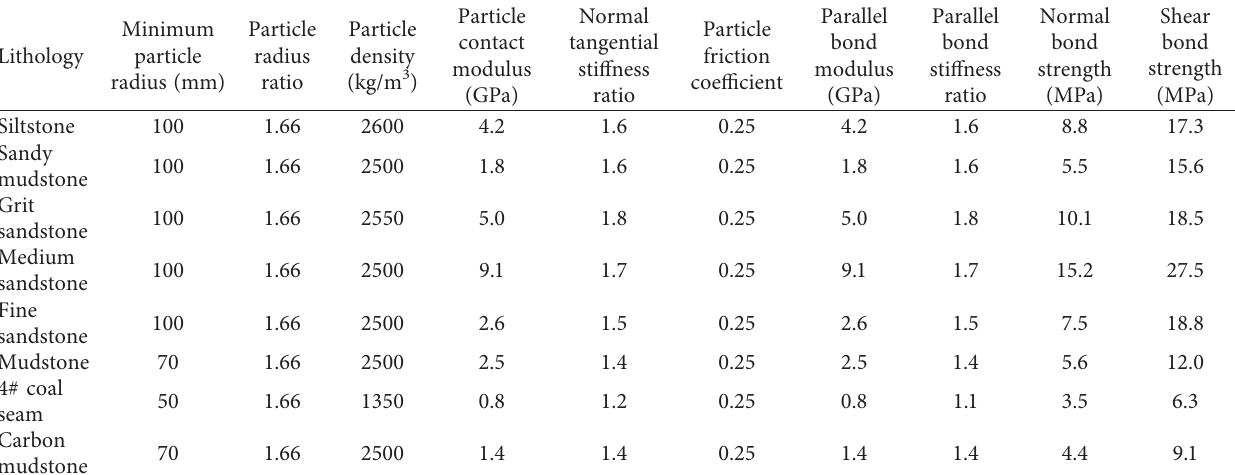
Figure 5: Calibration curves of the parameters of coal rock mass. (a) 4# coal seam. (b) Surrounding rock. Table 1: Mesoscopic mechanical parameters of the particle model.